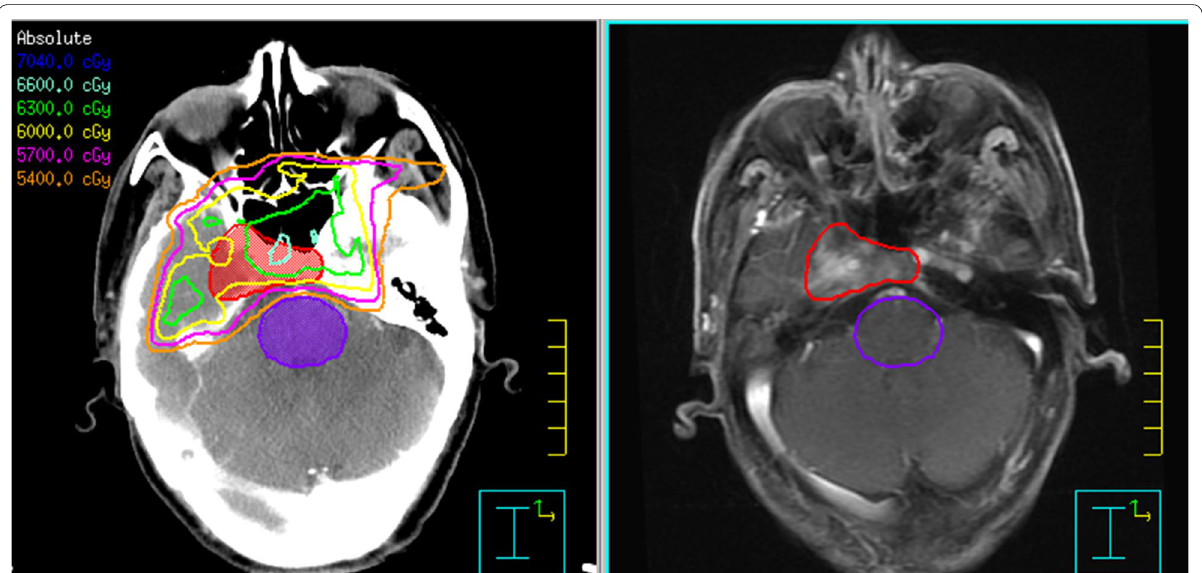
Fig. 1 Isodose distribution in a patient with nasopharyngeal carcinoma (NPC) extending to the right cavernous sinus. The right temporal lobe is close to the tumor. The gross tumor volume is delineated with a red line. Most of the tumor was underdosed. Although the maximum point dose of the right temporal lobe was 66.0 Gy, 95% of it received less than 60 Gy. The eyes, brain stem, left temporal lobe, optic chiasm, and optic nerves were spared from high‑dose